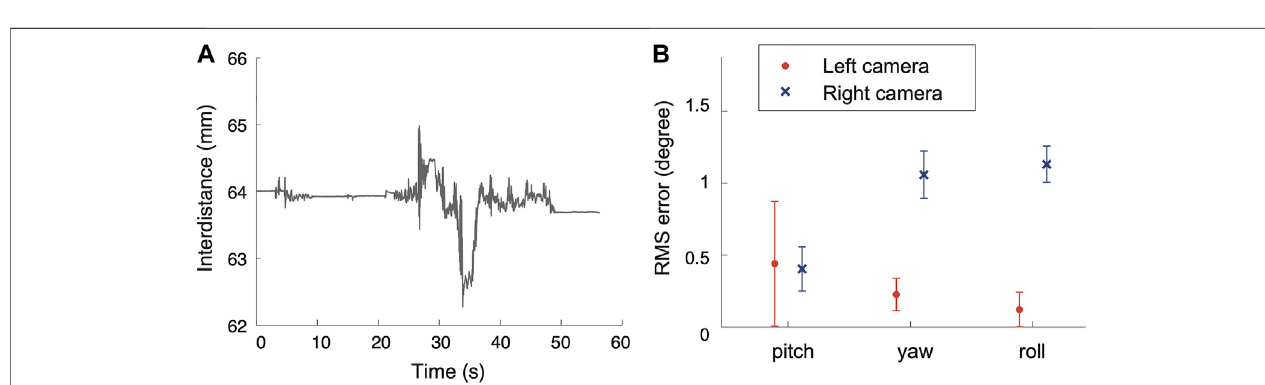
FIGURE 9 | Change in interlens distance (A) . RMS error of the direction of the lens (B) .